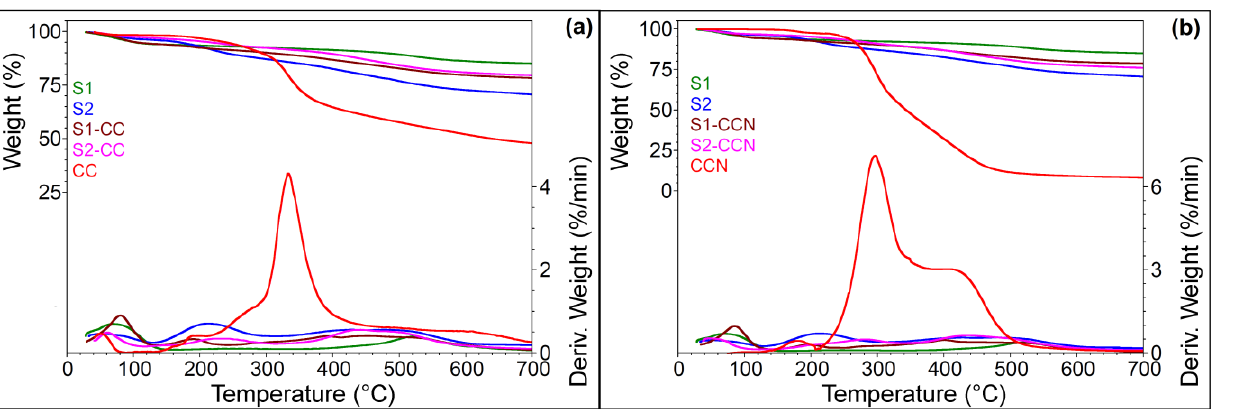
Figure 7. Thermogravimetric curves of hybrid materials modified with aminopropyl groups and CC dye ( a ) and hybrid materials modified with glycine residue and CCN dye ( b ). Table 3. Characteristic decomposition temperatures and mass losses of hybrid materials and curcumin